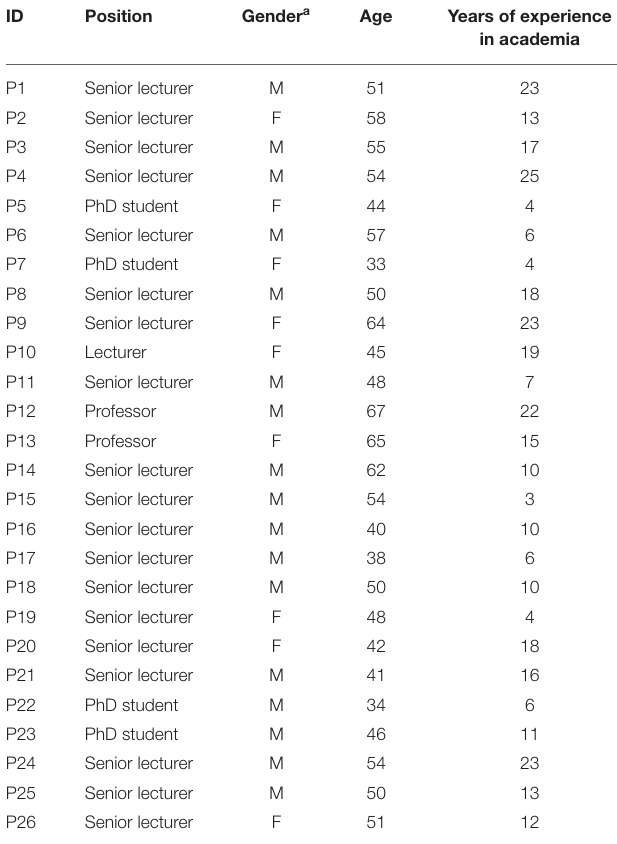
TABLE 1 | Participant